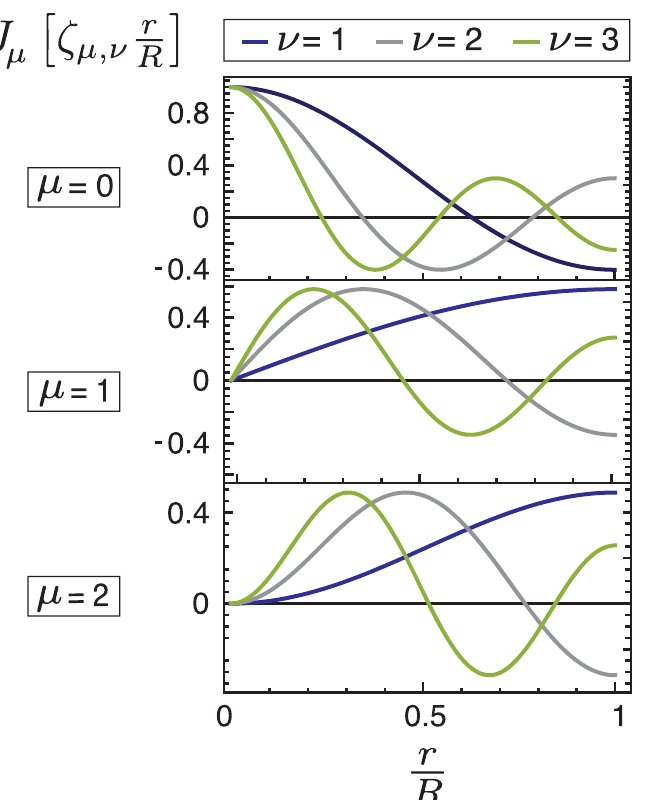
(cid:3) (cid:4) of (azimuthal) orders μ = 0, 1, and 2 for radial mode R